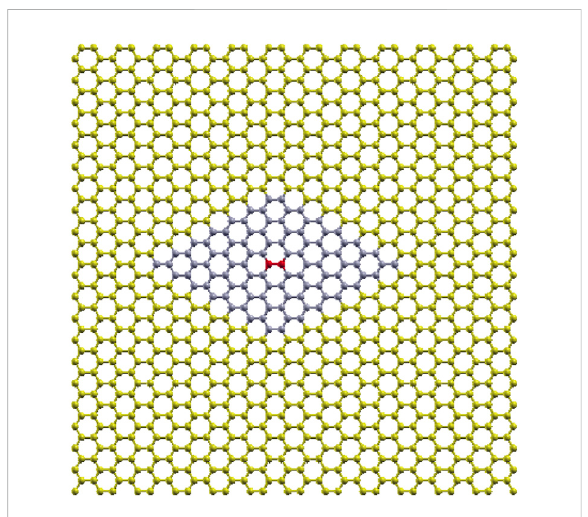
FIGURE 7 The 98 atom 7 × 7 hexagonal supercell (blue colored atoms) as part of the1,008 atomrectangular supercell of Figure 1. The red colored atoms in the center of the 7 × 7 hexagonal supercell are those corresponding to the two-atom primitive unit cell of graphene, which are displaced from equilibrium for the necessary force